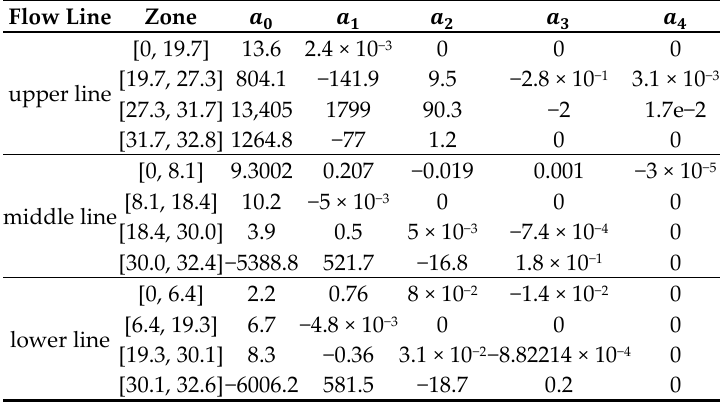
Figure 5. Flow lines of the aluminum alloy under extrusion within the porthole die: ( a ) FE simulation; ( b ) extracted flow lines and polynomial fitting. Table 3. Polynomial coefficients of the flow lines shown in Equation